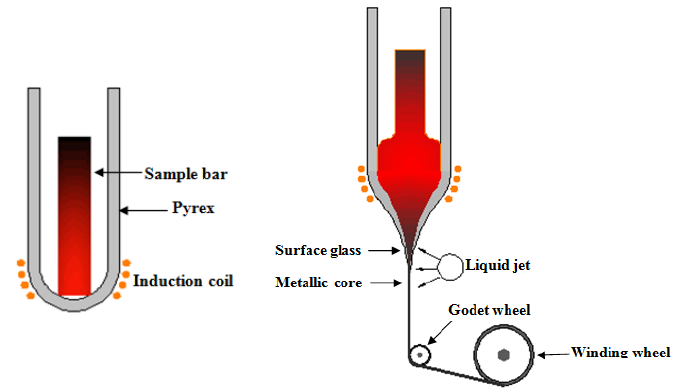
Figure 1. Schematic illustration of the Taylor technology for preparation of fibers.